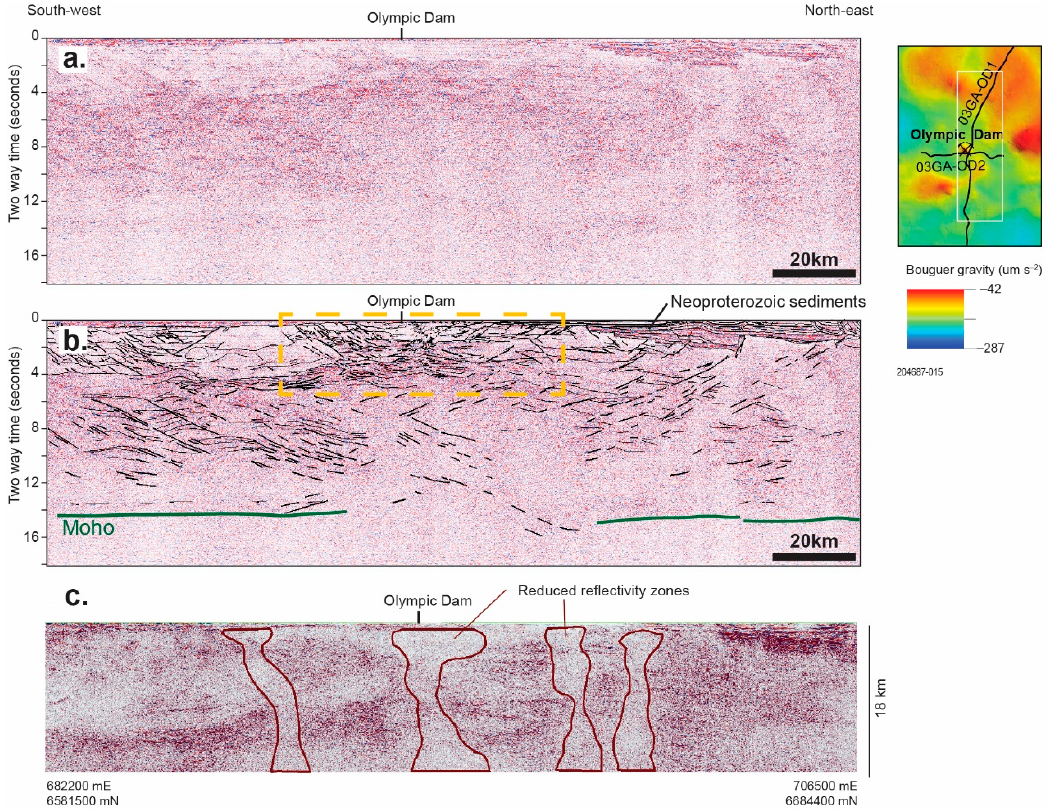
Figure 4. Reflection seismic images across Olympic Dam region, eastern Gawler Craton. Seismic line 03GA-OD1 of Geoscience Australia. ( a ) Uninterpreted seismic reflection data from [89]. ( b ) Interpretations of seismic reflection data simplified after [89]. ( c ) Detail of Olympic Dam region upper crust with data reprocessed to enhance vertical structural elements after [90].